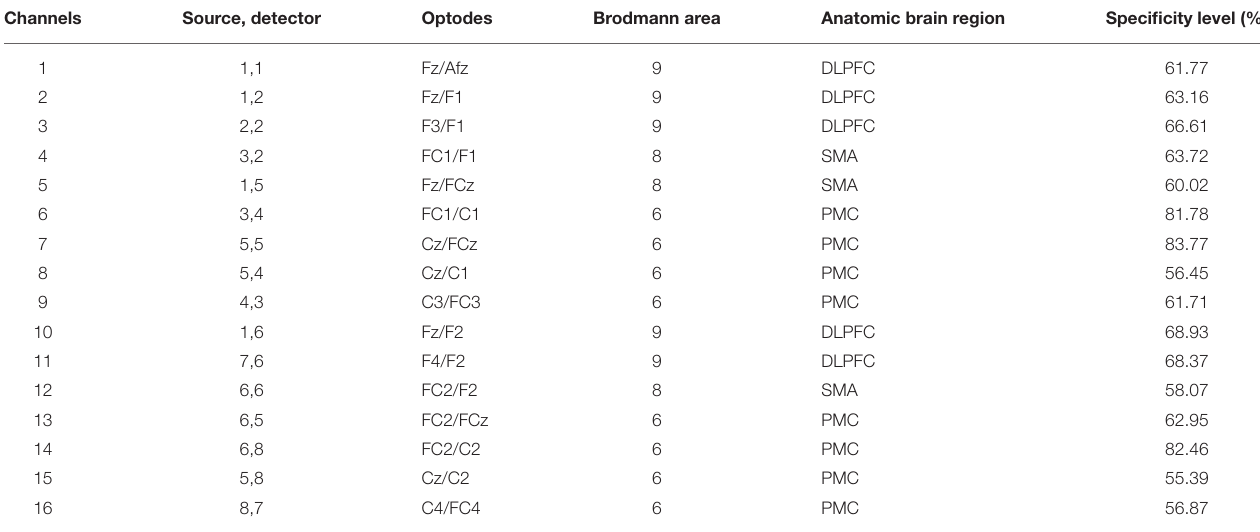
TABLE 1 | Description of the 16 channels of the fNIRS system; source/detector combinations, anatomic locations, and individual channel specificity. Channels Source, detector Optodes Brodmann area Anatomic brain region Specificity level